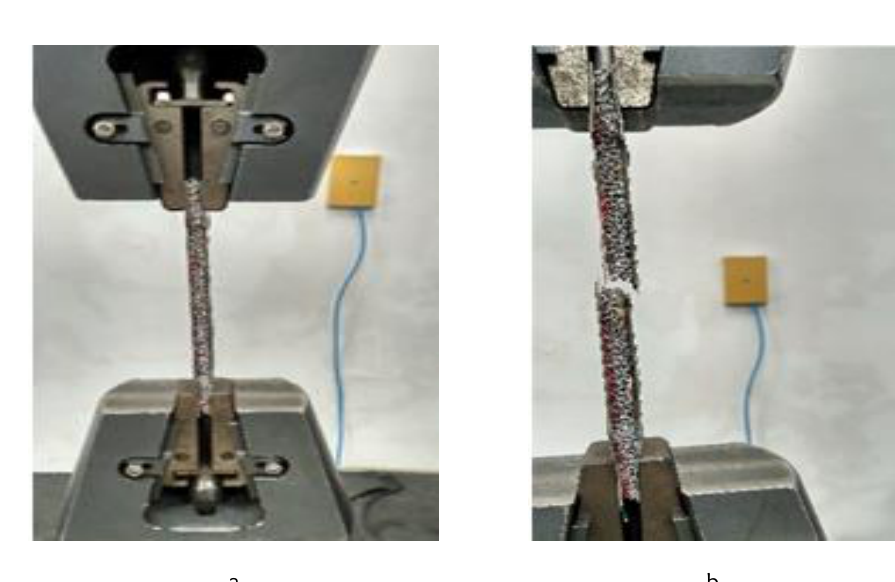
Figure 3: (a) Setup of the specimen on the tester machine, (b) The broken